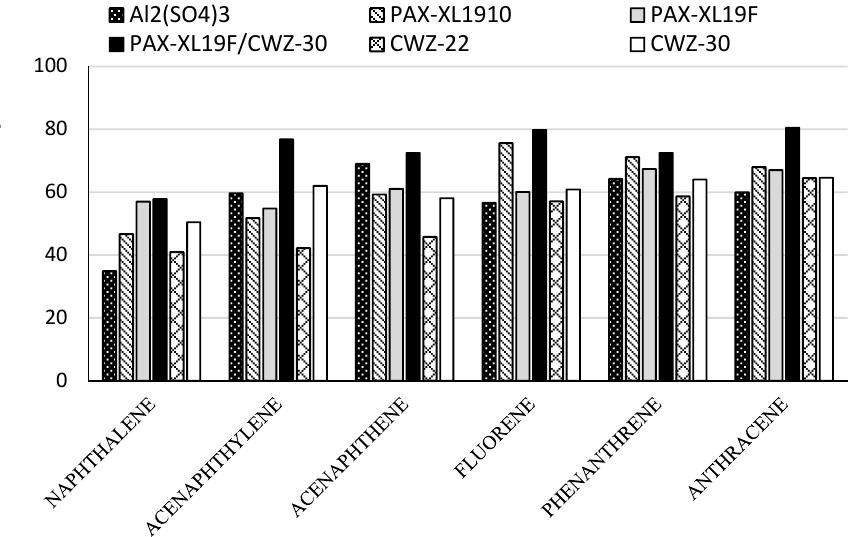
Figure 3. Removal efficiency of 2 ‐ and 3 ‐ ring PAH from surface water.